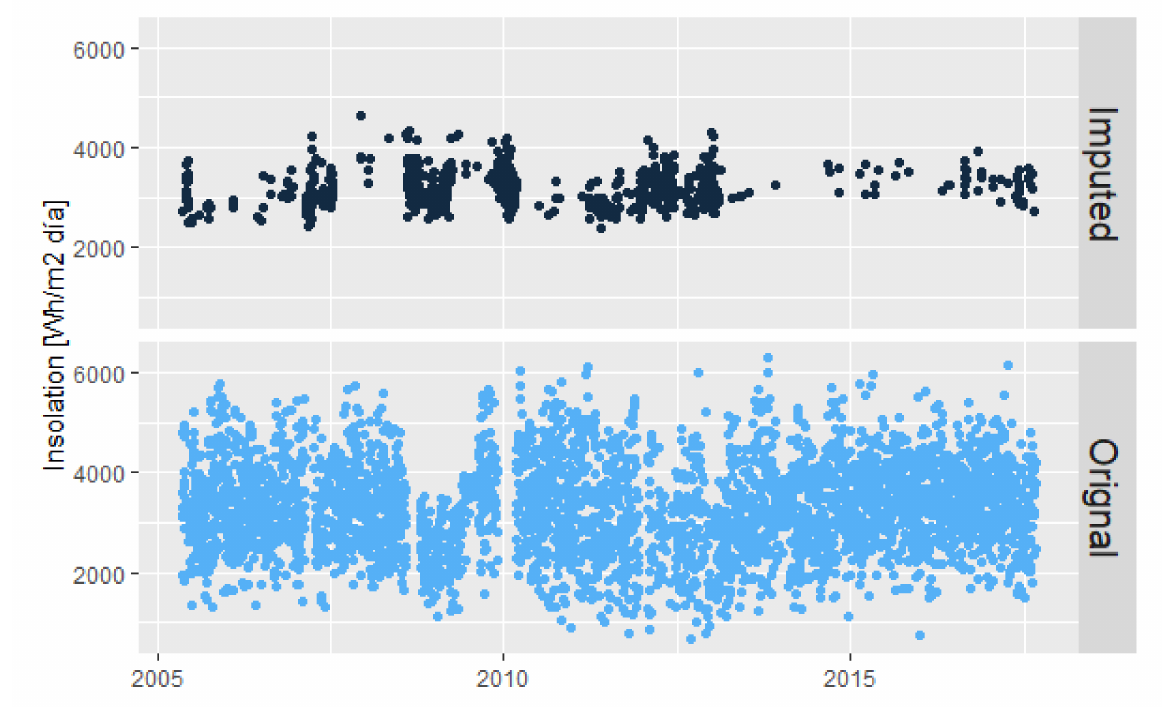
Figure 15. Universidad de Nariño imputation.